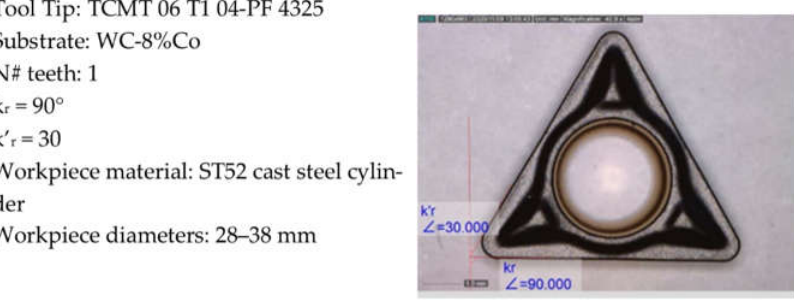
Figure 3. Geometrical tool parameters.